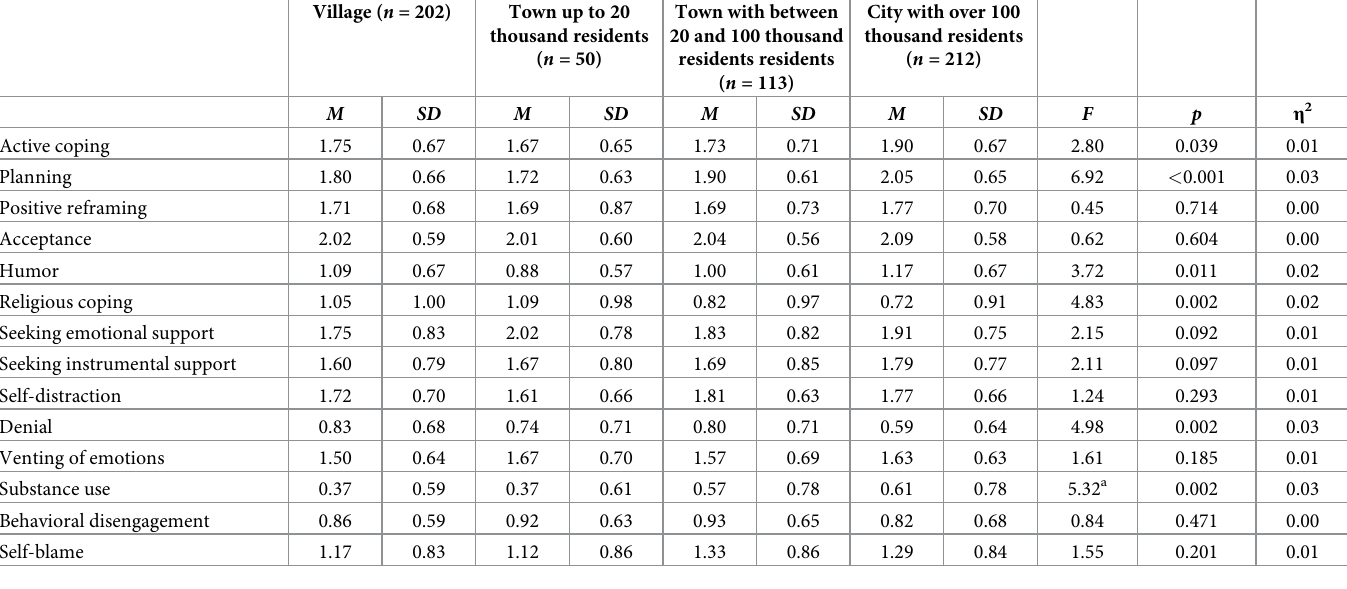
Table 8. One-factor analysis of variance of differences in strategies of coping with stress depending on place of residence. Village ( n = 202)